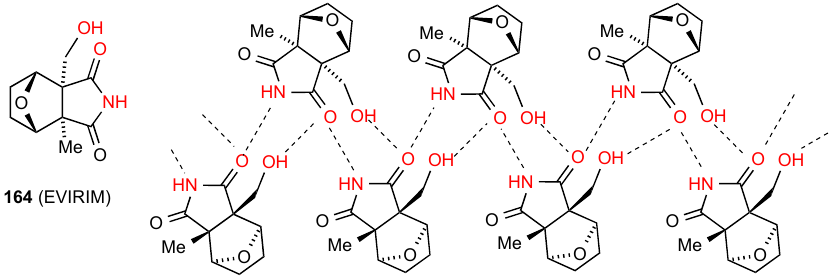
Figure 49. Structure adopted by compound 164.